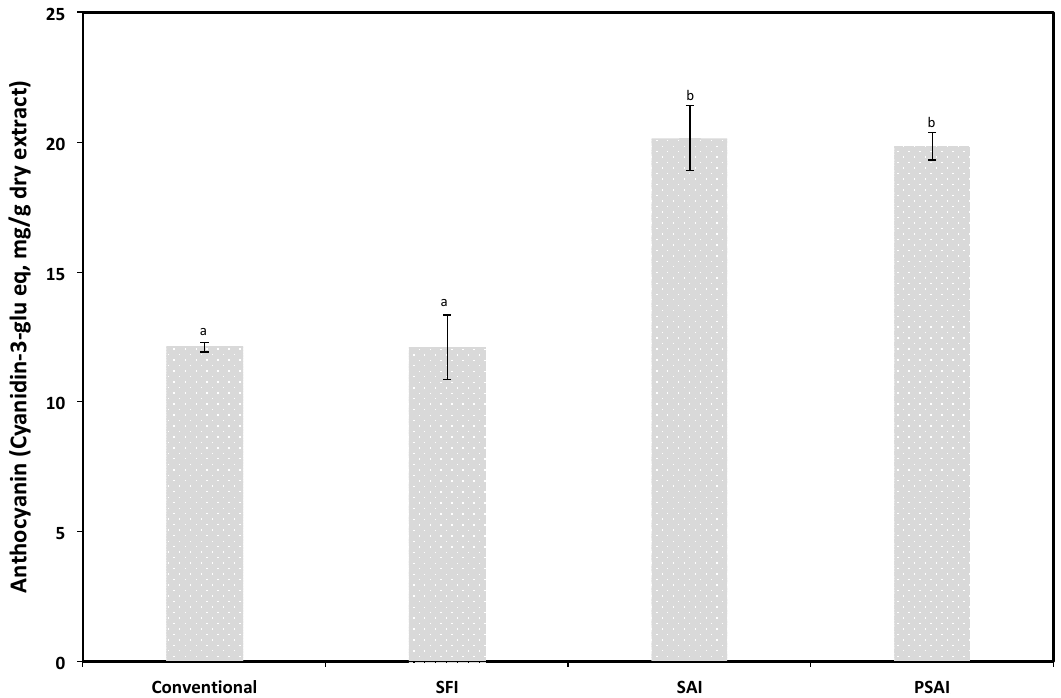
Figure 4. Anthocyanin content expressed in equivalents of cyanidin-3-glucoside for each extract obtained using different pretreatments. Lower case letters (a,b) represent significant differences between the anthocyanin content present in each extract submitted to different pretreatment conditions ( p < 0.05).